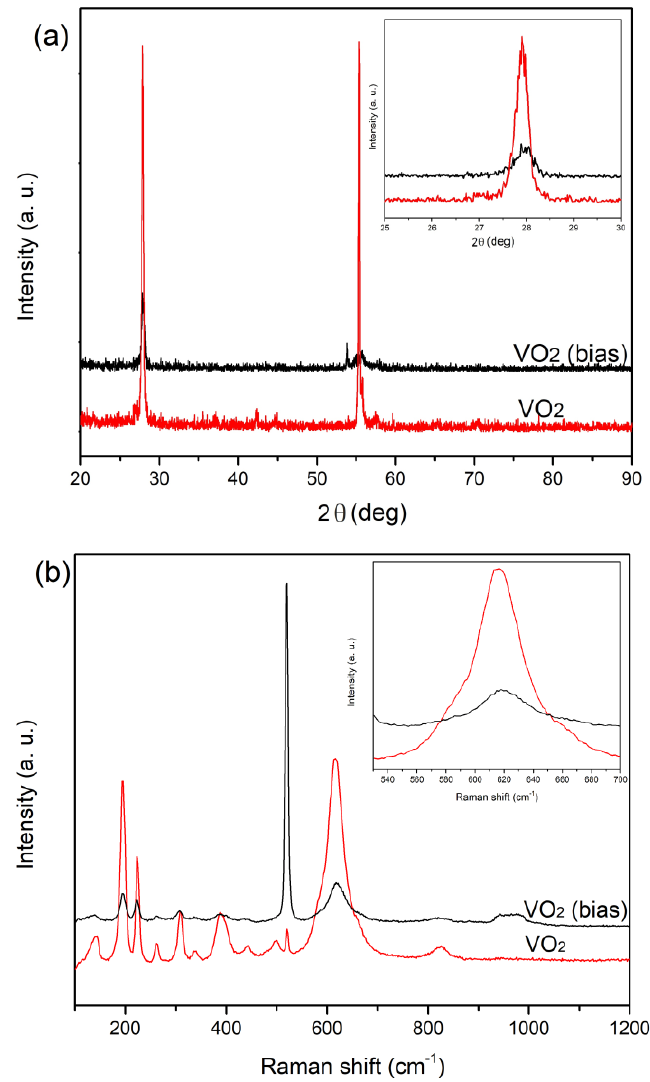
Figure 9. ( a ) X-ray diffraction patterns and ( b ) Raman spectra of VO 2 thin films (red) and VO 2 thin films deposited with 173 V bias (black).